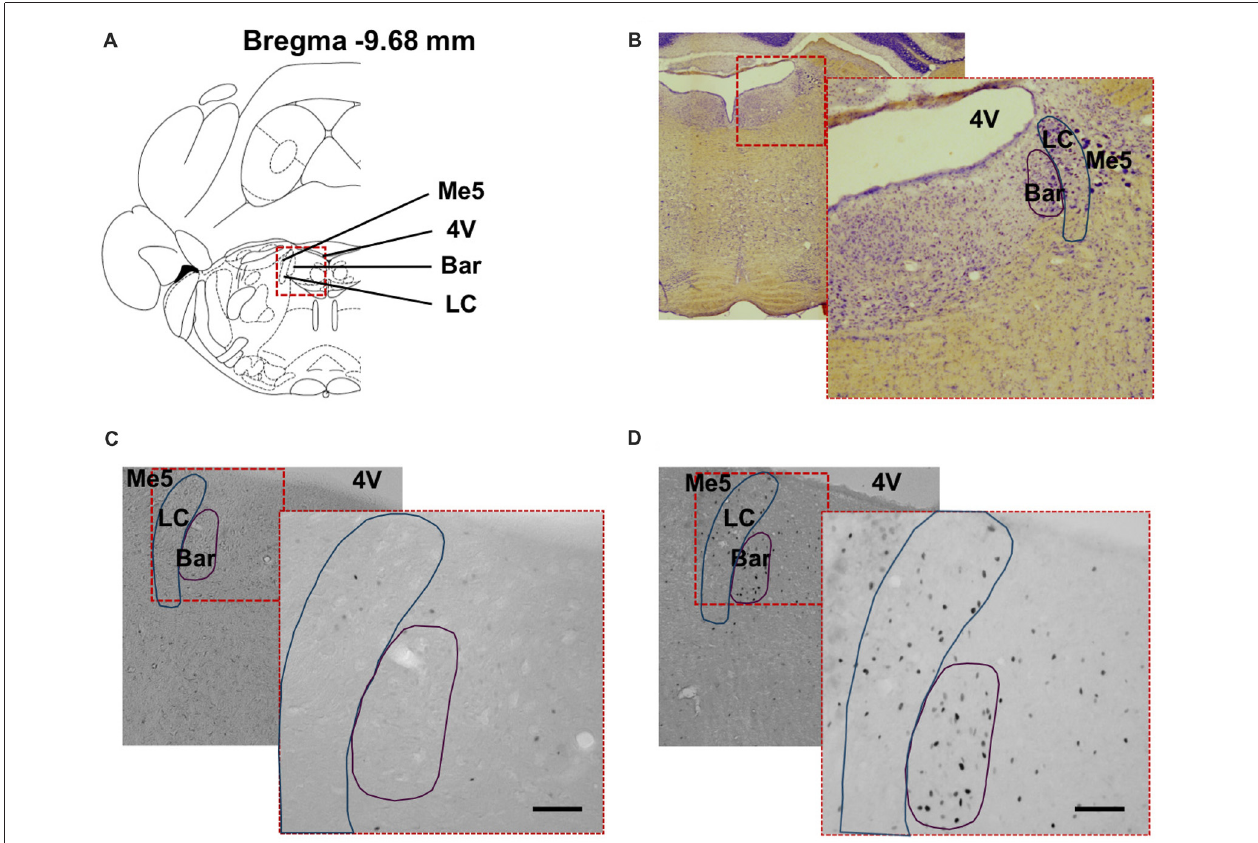
FIGURE 7 | Distribution of cFos immunoreactive cells in the pontine structures. (A) Coronal diagram of the rat brain at corresponding Bregma level AP − 9.68 mm (Rat brain atlas, Paxinos and Watson, 2007). Representative low power photomicrographs of coronal brain sections stained (B) with Nissl staining and for cFos showing the dorsal pons of (C) non-stimulated (Sham) rat and (D) stimulated rat (Stim) with bipolar stimulation electrode implanted in the bladder wall at the dome and neck levels. The higher power photomicrographs in the lower right corners show the PMC and locus coeruleus. 4V, fourth ventricle; PMC, Pontine micturition center or Barrington’s nucleus; LC, locus coeruleus; Me5, mesencephalic trigeminal tract. Scale bar = 150 µ